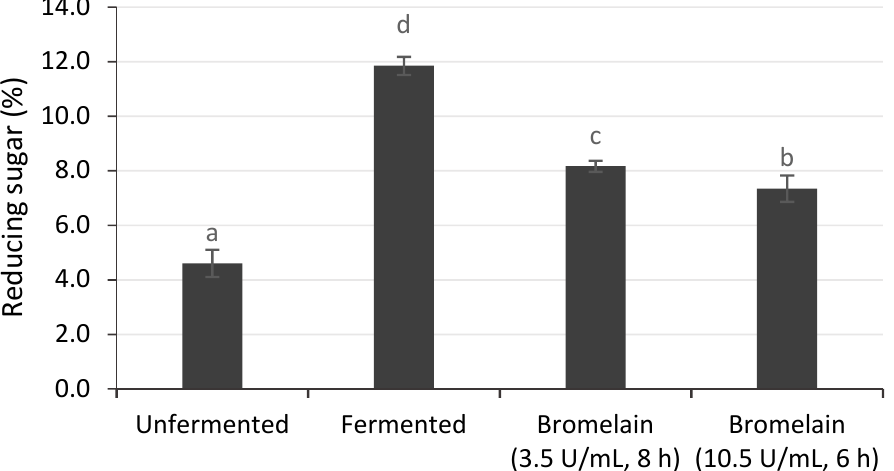
Figure 4. Total polyphenols of unfermented cocoa beans hydrolyzed by bromelain. Unfermented Figure 3. Reducing sugar of unfermented cocoa beans hydrolyzed by bromelain. Unfermented and and fermented cocoa beans were used as controls. a–d Indicate the significant difference ( p < fermented cocoa beans were used as controls. a–d Indicates the significant difference ( p < 0.05).